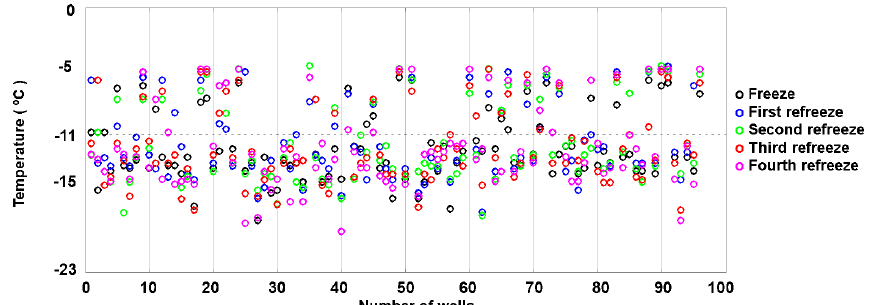
Figure 13. Well-by-well results of a refreeze experiment performed with apoferritin (batch 2), second experiment with 0.036mgmL − 1 of Fig. 12. Table 3. Freezing statistics of refreeze experiments performed with apoferritin solutions, batch 2, 0.018mgmL − 1 . First experiment Second experiment Third